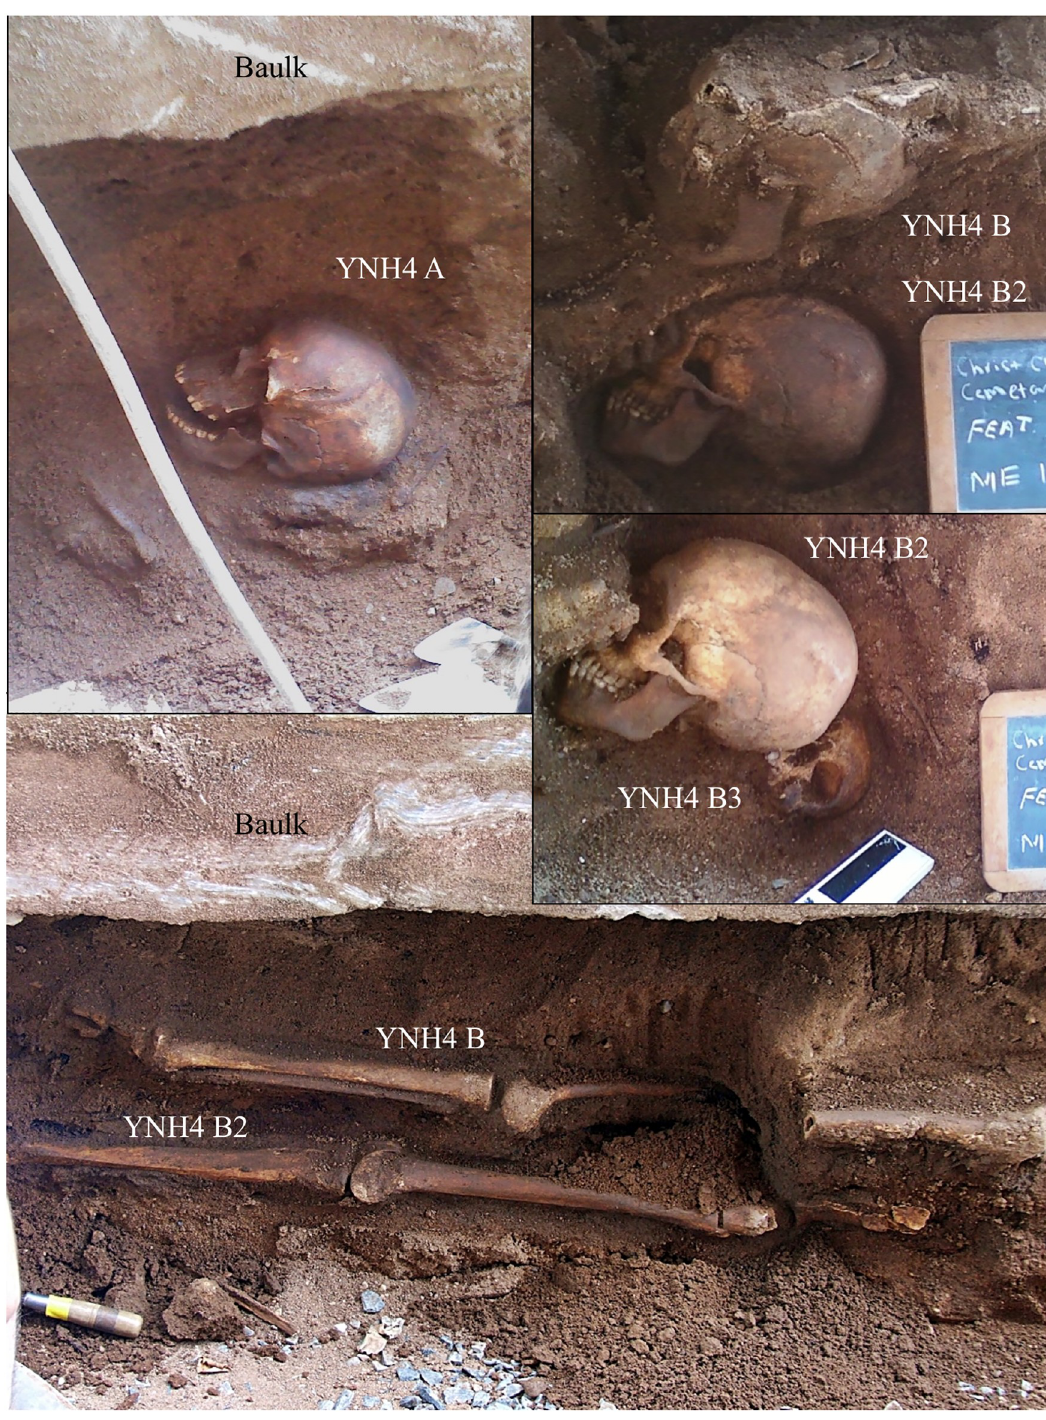
Fig 1. Clockwise from top left: YNH4 individual A in situ; B and B2 crania in situ; B2 and B3 crania in situ, B and B2 postcrania in situ. Note concrete baulk directly above burials.